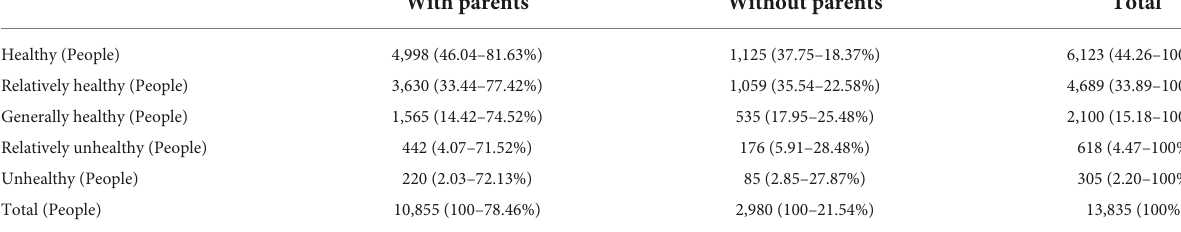
TABLE 4 Mental health status of adolescents growing up with or without parents.